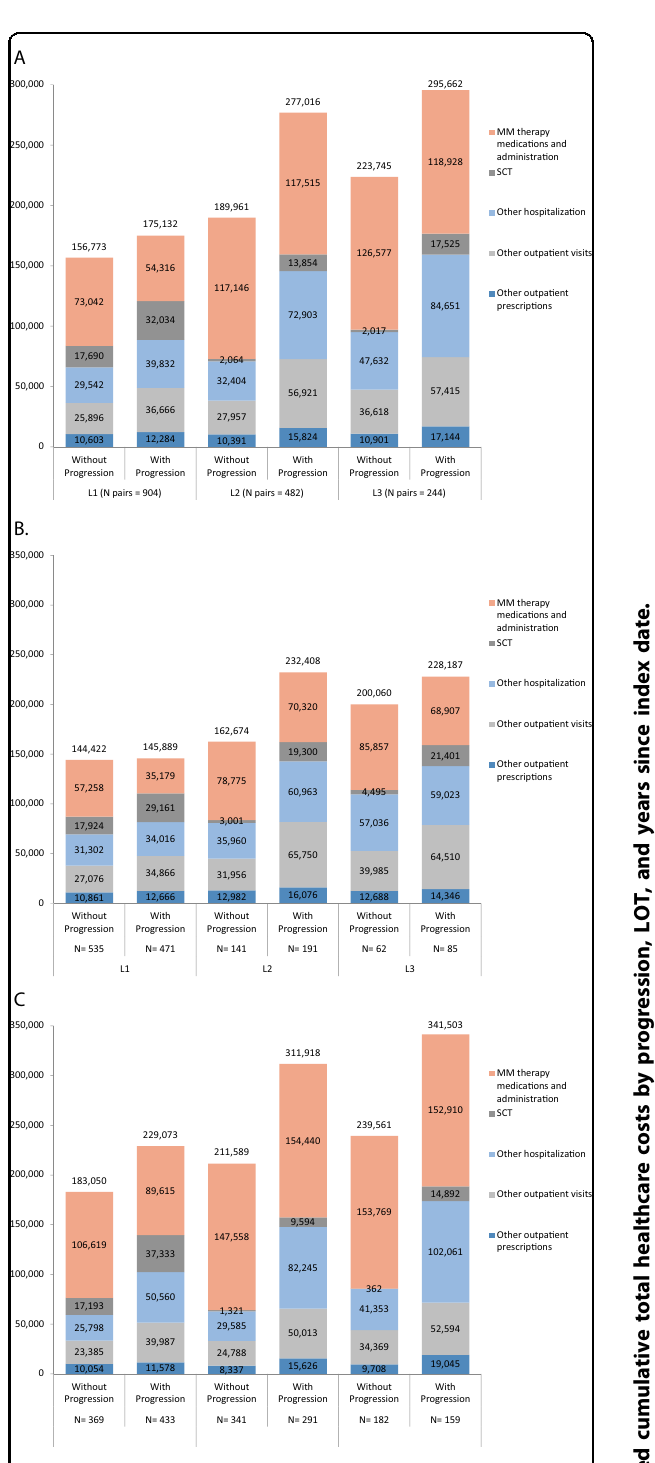
Fig. 5 IPTW adjusted mean annual healthcare costs among patients with versus without progression by LOT. A LOTs initiated between 2006 to 2018; B LOTs initiated between 2006 to 2012; C LOTs initiated between 2013 to